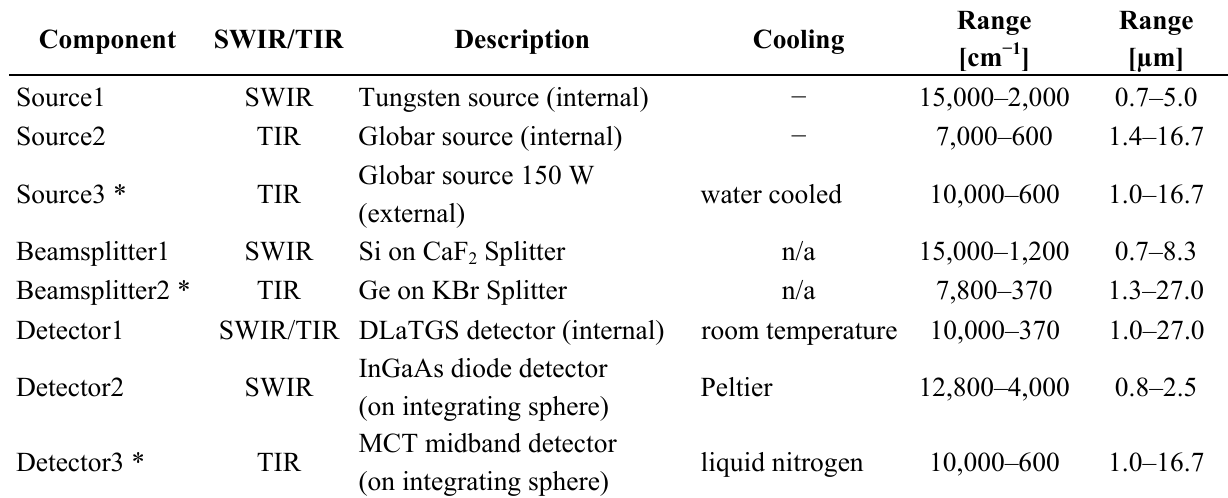
Table 1. Spectrometer components and their spectral